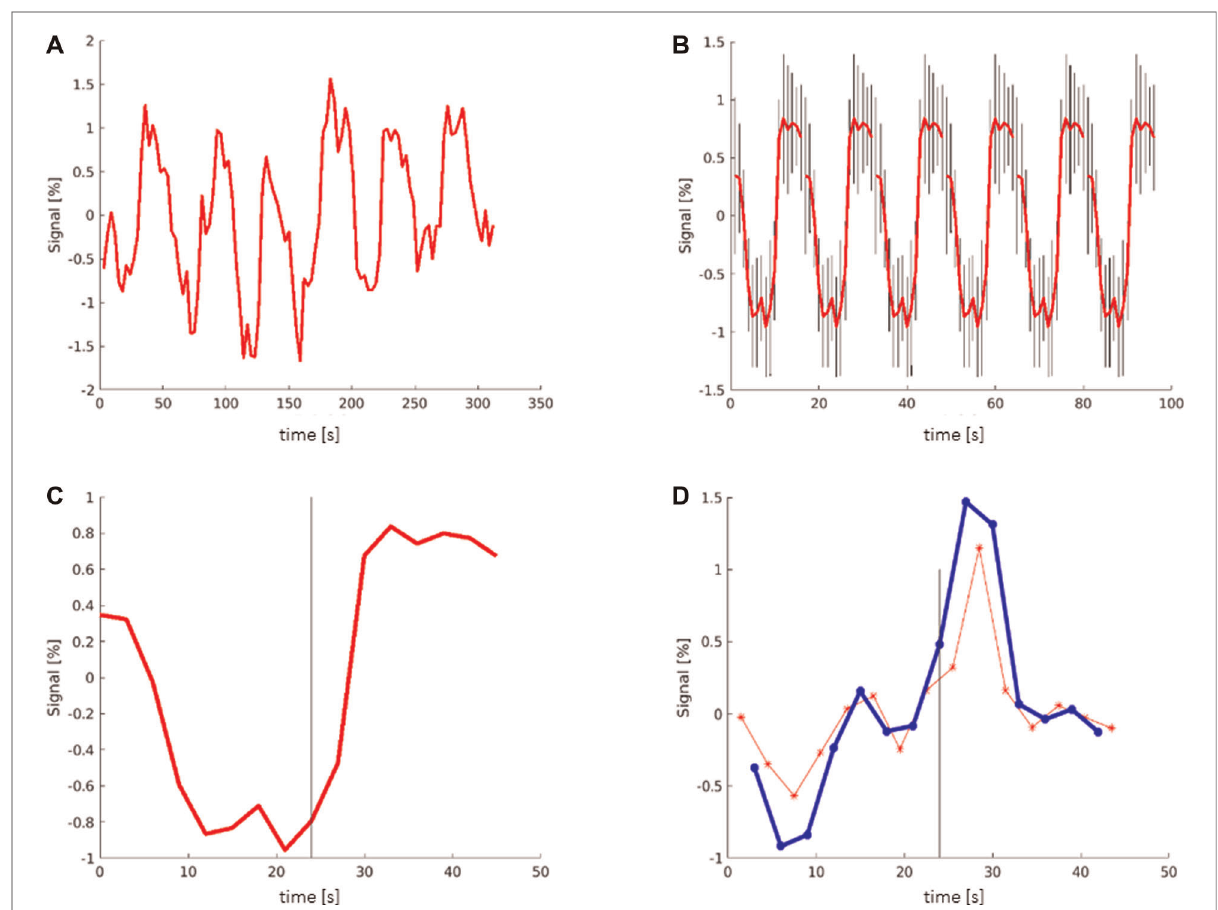
FIGURE 1 Creation of time courses: ( A ) TC (time course) showing the averaged signal of all voxels in the selected region (here: Broca ’ s area). The y -axis shows the deviation of the signal from the mean value. ( B ) TC averaged over all 6 periods, including the maximum deviation (black bars) of the signal. ( C ) TC showing one period that contains the mean information of all 6 periods; black bar signals the start of the activation block at 24 s. ( D ) Red graph showing the derivation of the TC representing the slope (referring to the next time point (TP)). Blue graph showing the derivation of the TC representing the slope (referring to the second TP); black bar: start of the activation block at 24